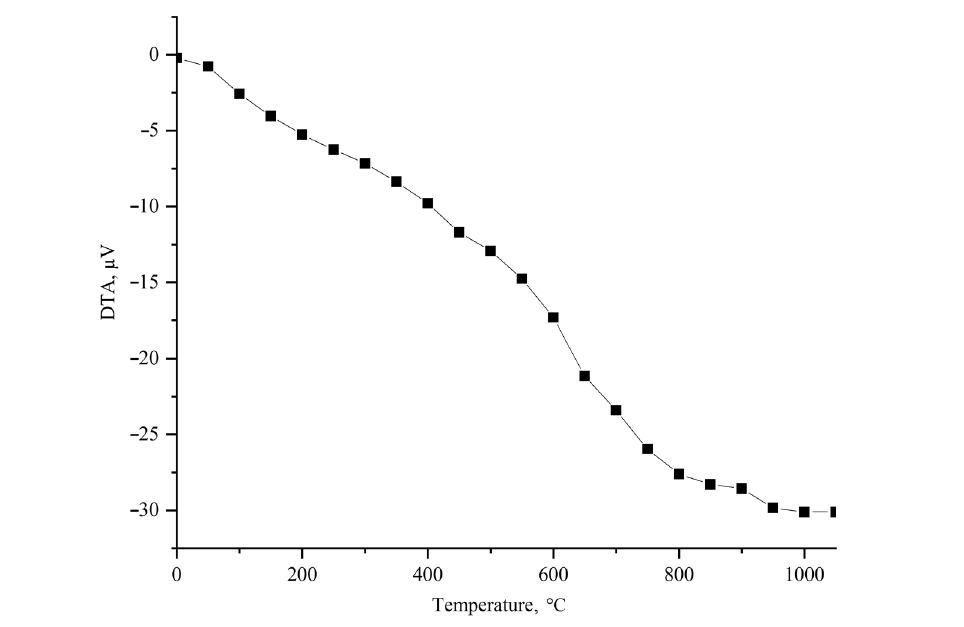
Fig. 2. The DTA curve of Uvurjargalant oil shale.